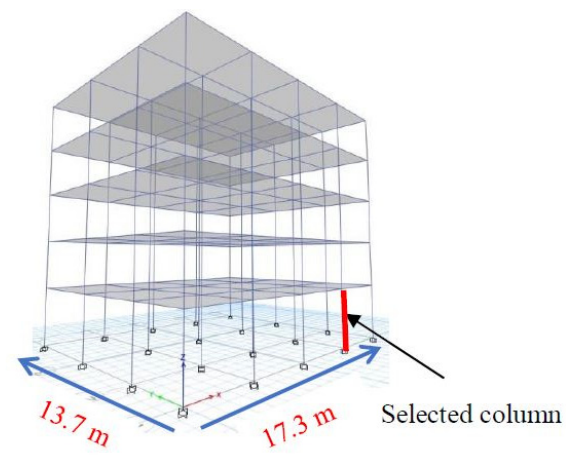
Figure 1. Finite element model and detailed information about the selected building.